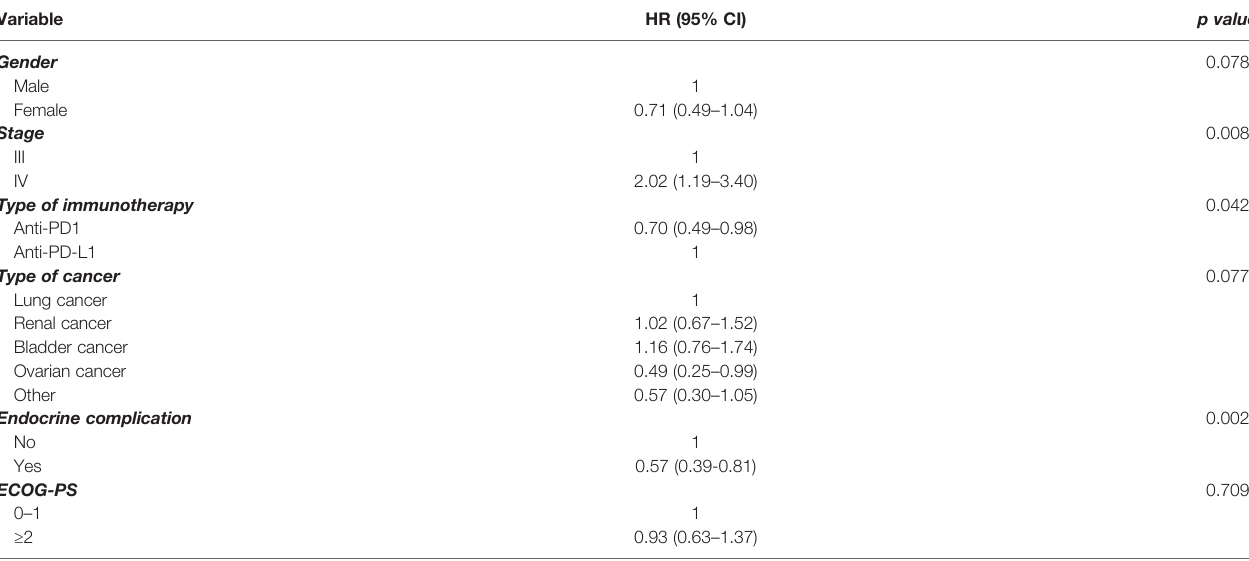
TABLE 2 | Multivariate analysis for progression-free survival (PFS).